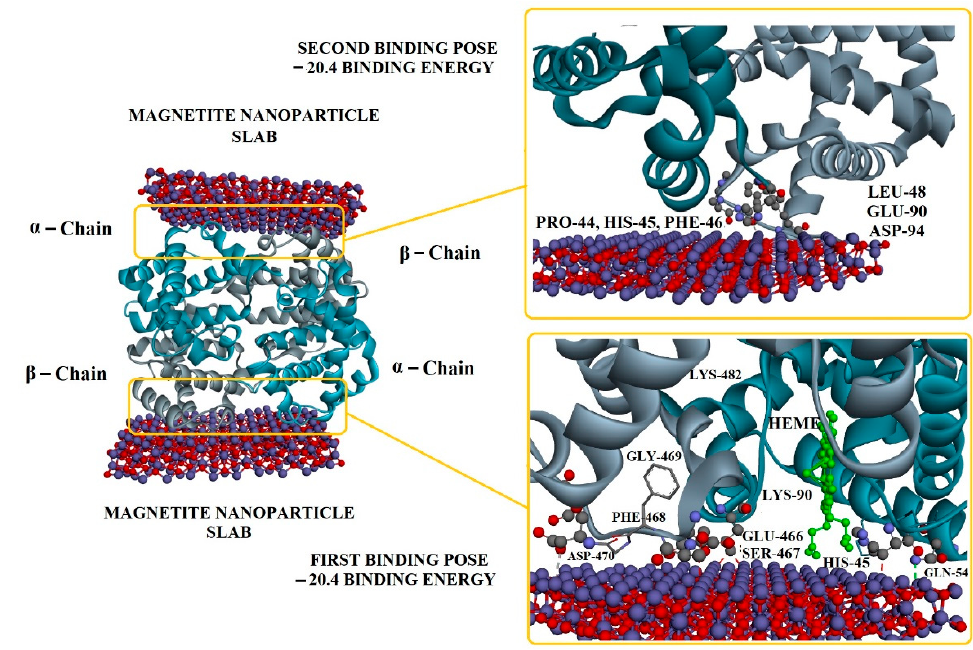
Figure 1. Interaction of hemoglobin HbA1 with bare magnetite nanoparticle slab.